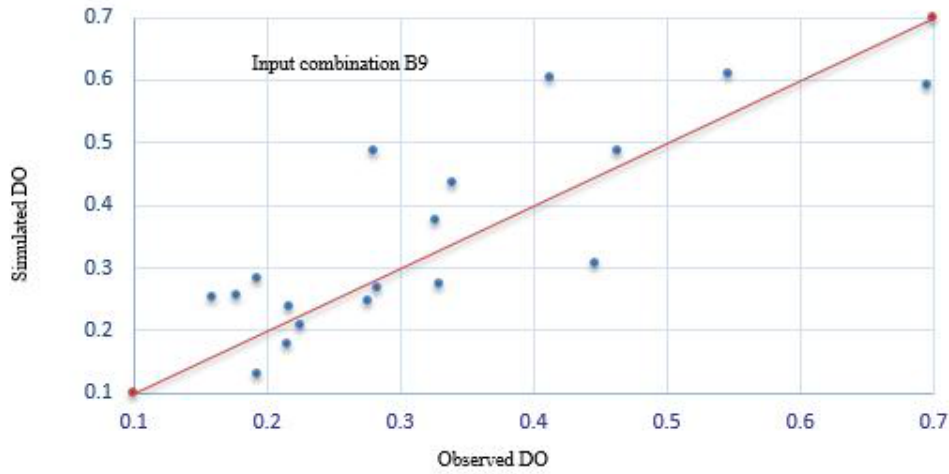
Fig. 4: linear relation between observed and forecasted data